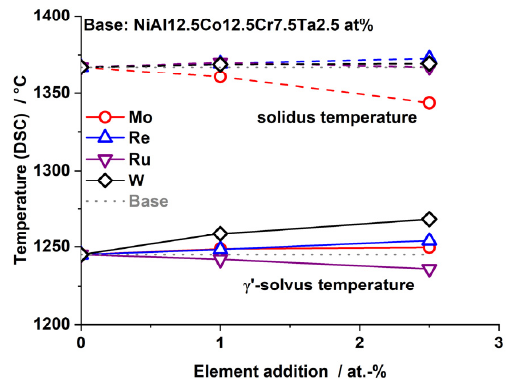
Figure 3. Influence of solid solution strengthening elements on the transformation temperatures measured by DSC of the EXP alloy series.